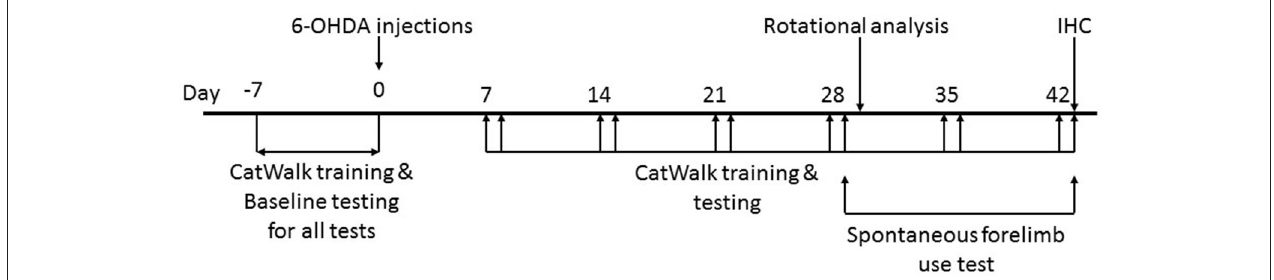
FIGURE 1 | Timeline of the study. Animals were handled daily for 1 week prior to surgical intervention to make them amenable to human interaction. CatWalk TM XT training and baseline testing for CatWalk TM XT gait analysis, rotational analysis, and the spontaneous forelimb use test were conducted in the week preceding the 6-OHDA lesions. Behavioral testing was resumed on day 7 after the surgical intervention with training on the CatWalk TM XT on days 7, 14, 21, 28, 35, and 42 followed by acquisition of gait parameters with the CatWalk TM XT software on days 8, 15, 22, 29, 36 and 43. The spontaneous forelimb use test was conducted on day 29 and 43 after the CatWalk TM XT gait analysis. Rotational analysis was performed on day 30. All animals were sacrificed on day 43 after behavioral